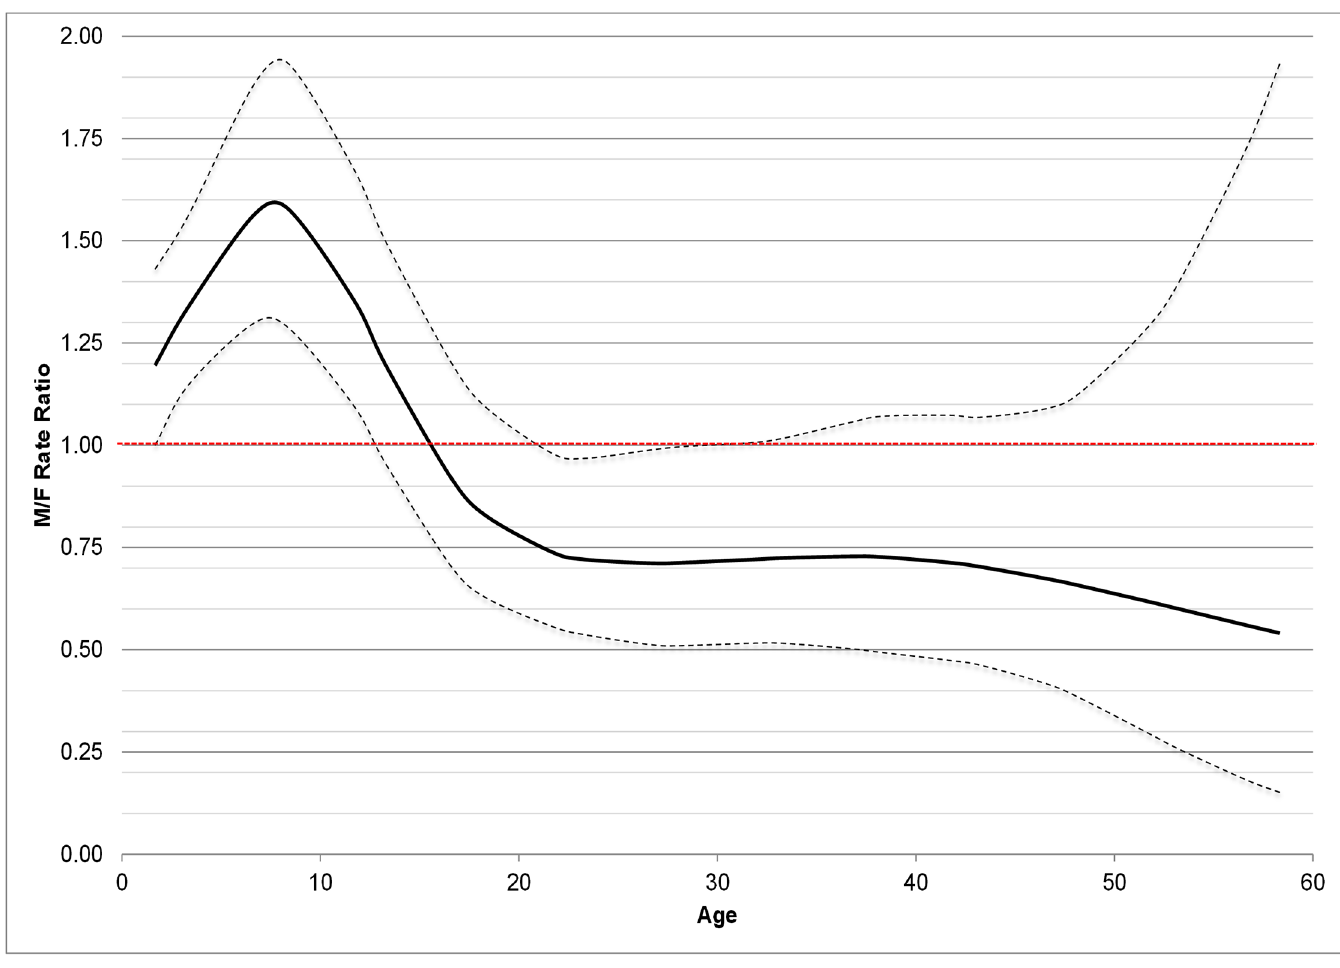
Fig 4. Incidence rate ratios (RR, with 95%CI) of asthma by age in men vs. women.